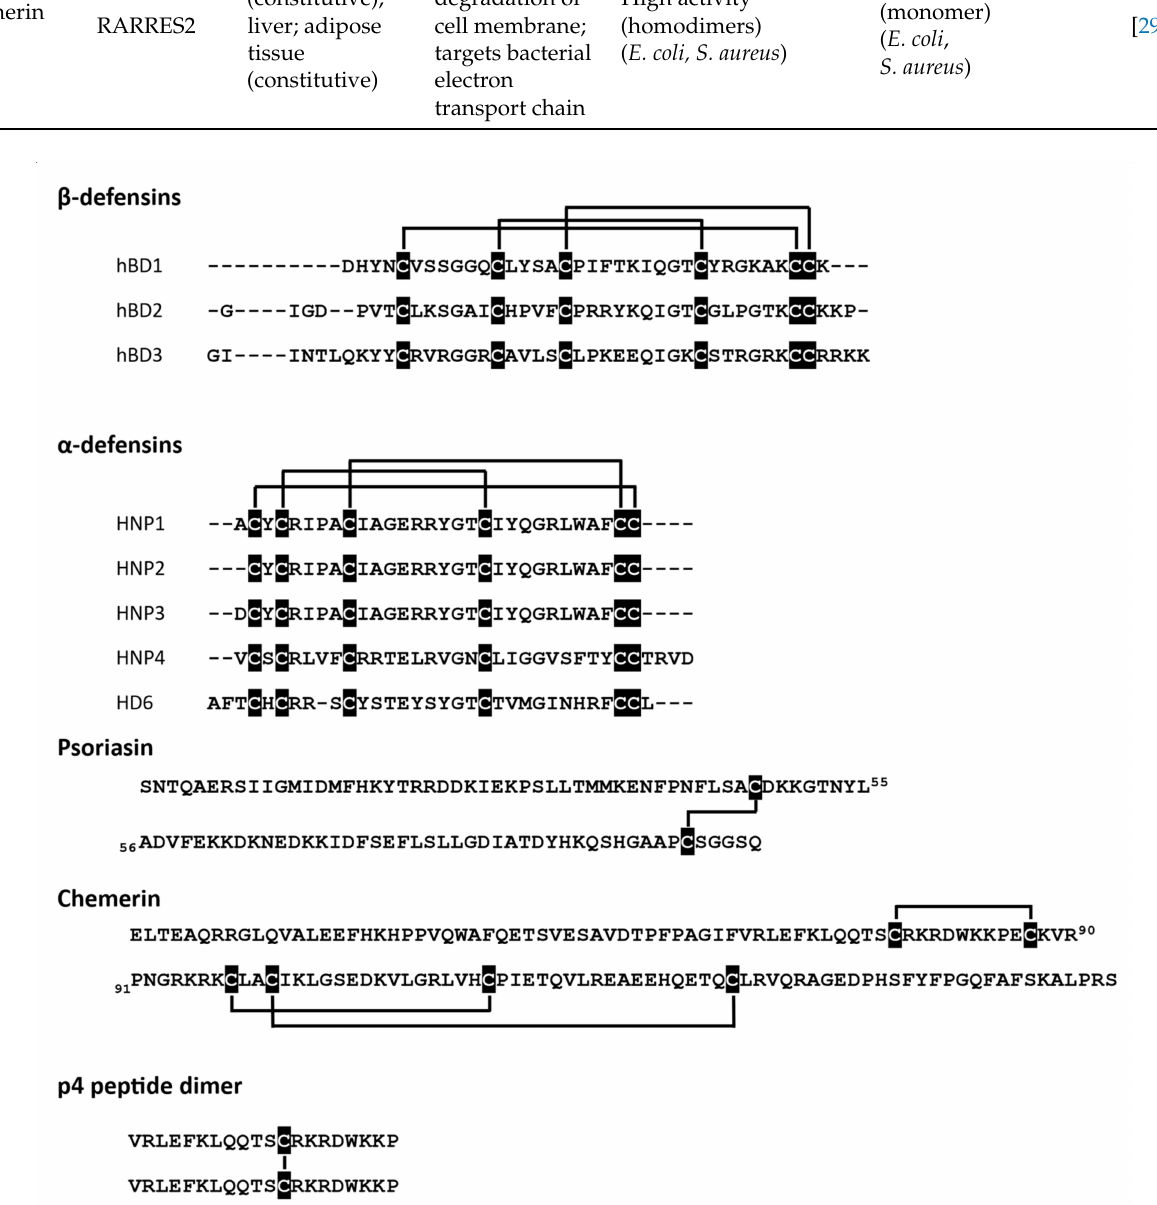
Figure 1. Redox-active AMPs with the indicated cysteine residues (black) and disulfide